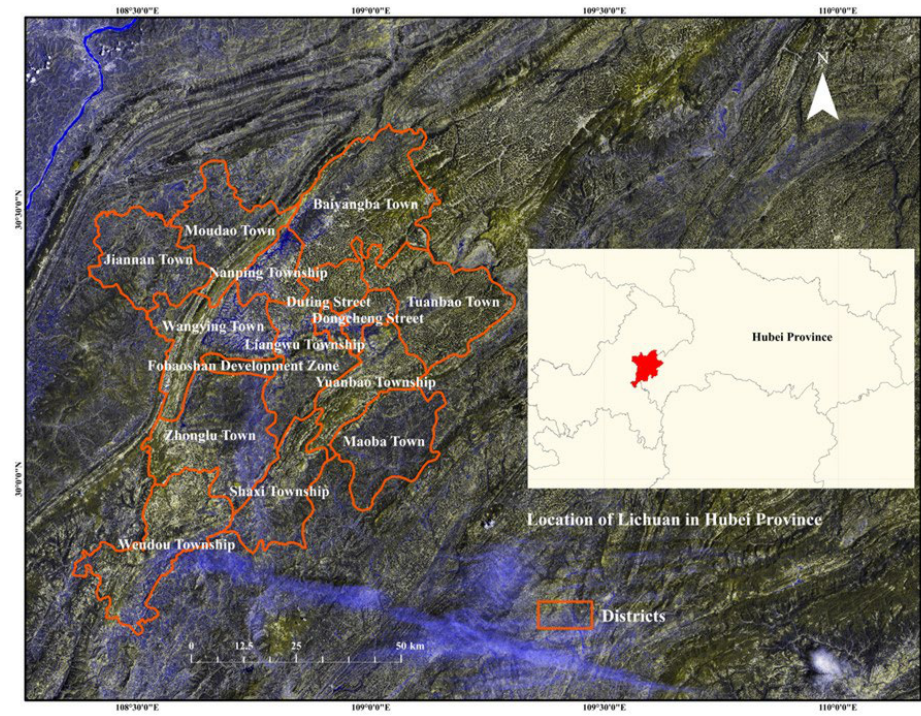
Figure 1. The geographical location of the audit sample.